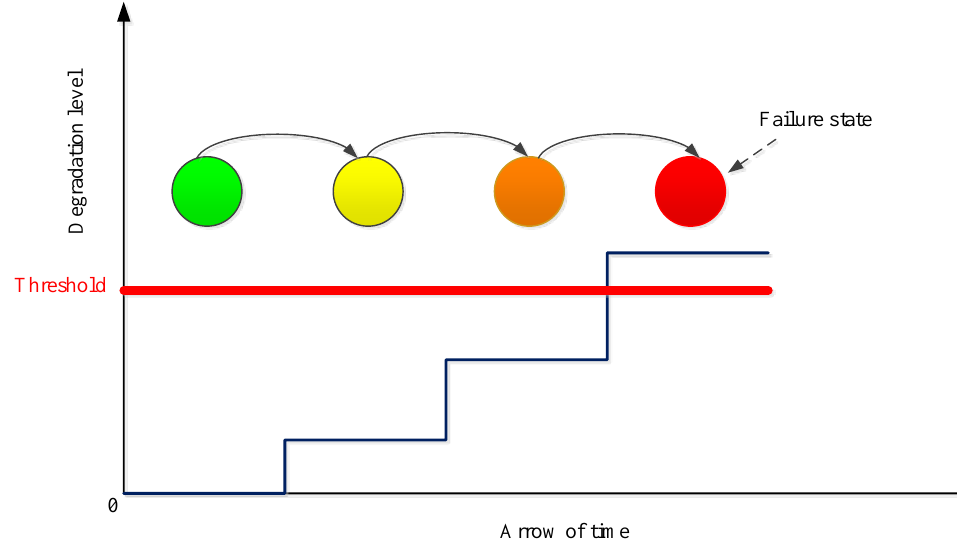
Figure 1. Illustration of a degraded system representation with four